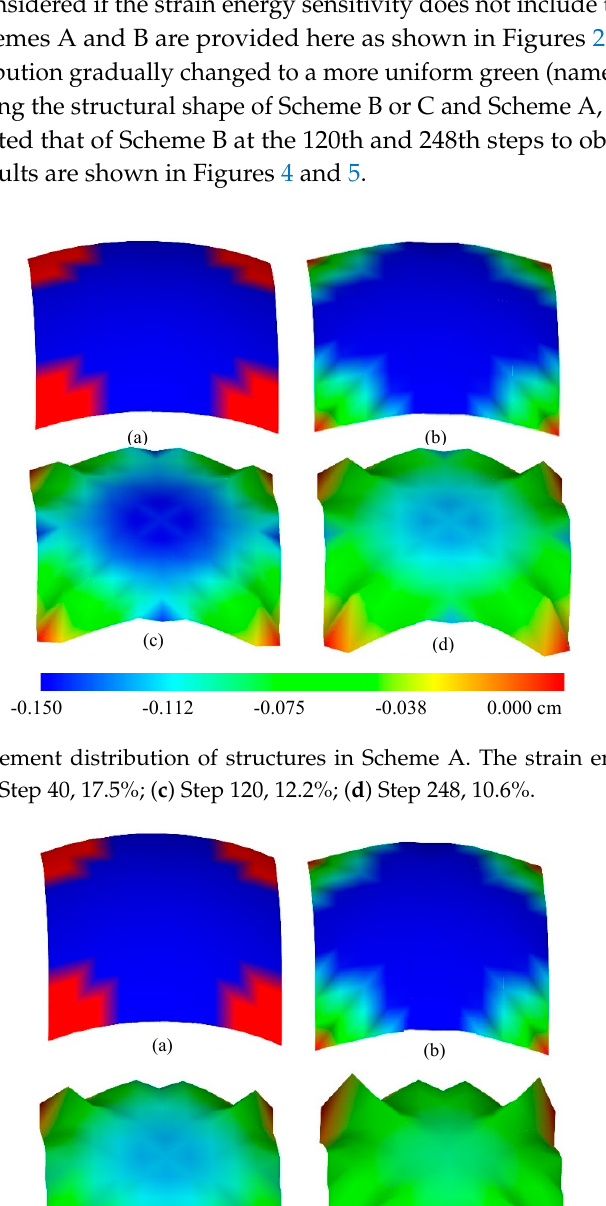
Figure 3. Z-displacement distribution of structures in Scheme B. The color bar is the same as Figure 2. The strain energy change ratio: ( a ) Step 1, 100%; ( b ) Step 40, 17.6 %; ( c ) Step 120, 11.5%; ( d ) Step 248, 10.8%.